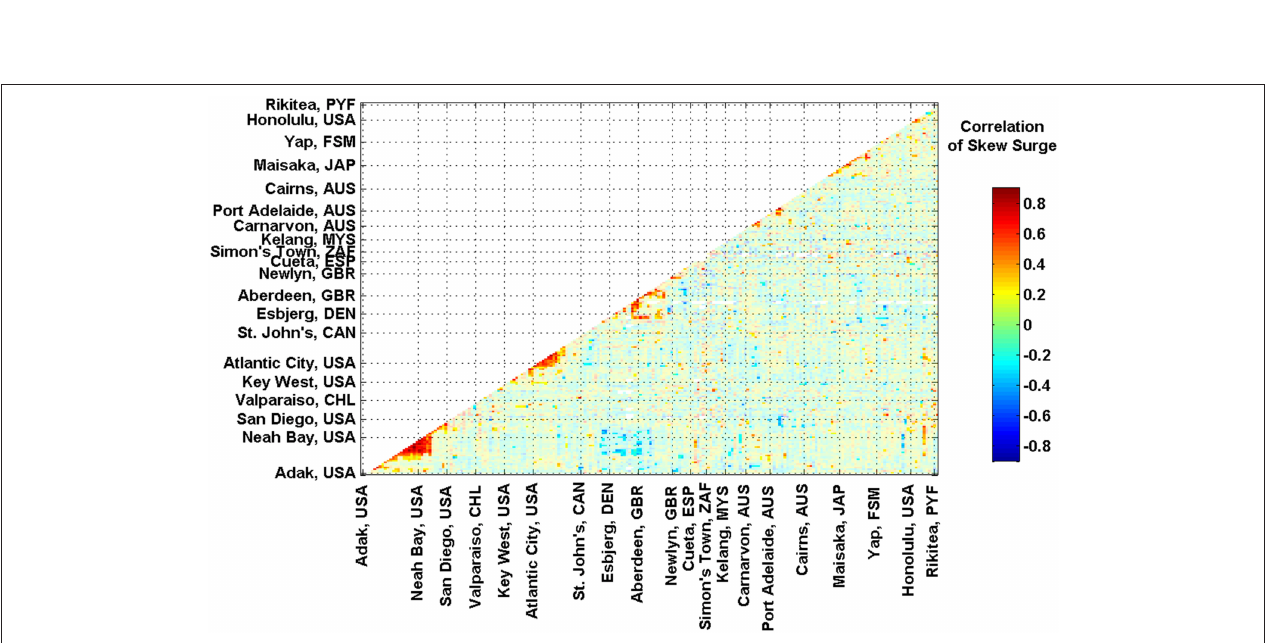
FIGURE 7 | Shows the magnitude of the trend in in the 99th percentile of (A) skew surge and (B) NTR, for the 220 sites analyzed. Large dots show that the trend is significant at the 95% level.